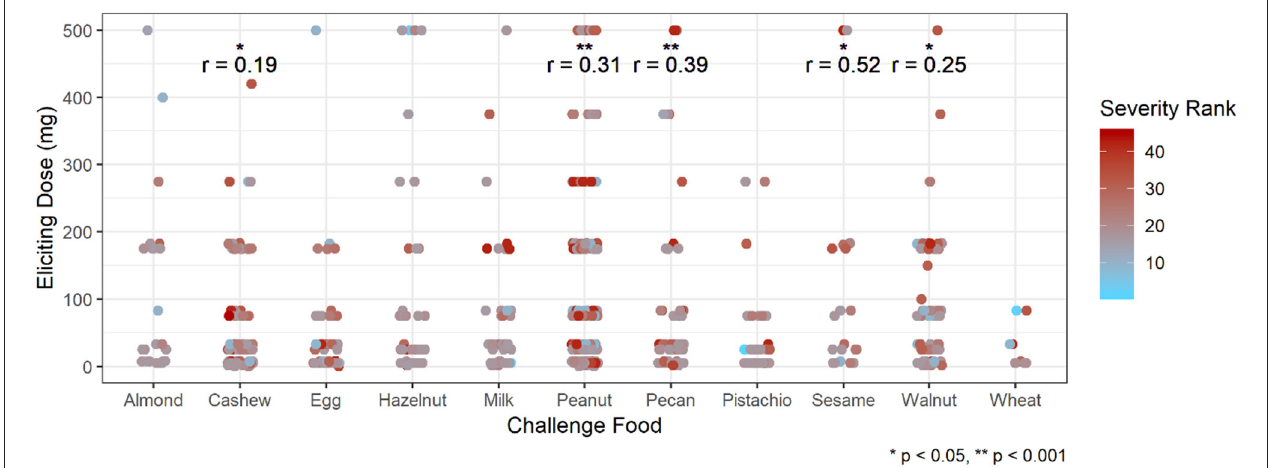
FIGURE 5 | Correlation of eliciting dose and adverse event severity ranking by challenge food. * p < 0.05, ** p < 0.001 by Spearman rank correlation test. Red ranking corresponds to more severe symptoms, while blue corresponds to more mild